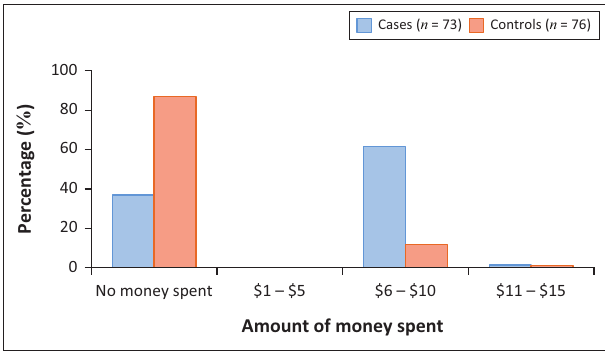
FIGURE 2: Average monthly transport expenses.